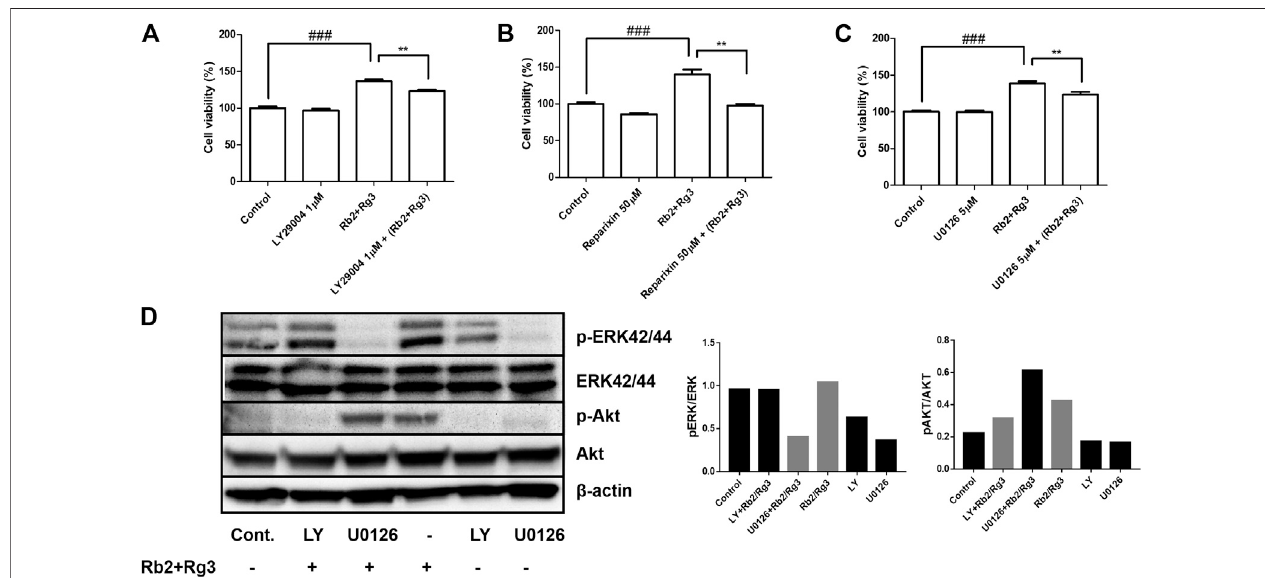
FIGURE 7 | Effects of selective inhibitors of Akt ( (A) ; LY294002), CXCR1/2 ( (B) ; Reparixin) and ERK ( (C) ; U0126) on Rb2/Rg3-induced cell proliferation as monitored by the CCK-8 assay, indicating the pro-proliferative effects of the combination were due to activation of at least those three pathways. The effect of the CXCR1/2 inhibitor was most profound and entirely inhibited the stimulation of cell proliferation due to ginsenoside treatment. Data represents mean ± SD, n (cid:2) 4. ** p < 0.005 and ### p < 0.001. (D) Phosphorylation of Akt and ERK by the combination of Rb2 and Rg3 in the presence or absence of LY294002 and U0126 as measured by western blotting and the density of bands were measured. LY294002 and U0126 completely inhibited the promoting effects of Rb2 and Rg3 on the phosphorylationofAktandERK,respectively.TheseresultsdemonstratethatAktandERK,andtheirphosphorylation,areessentialforthepro-proliferativeeffectsofthe Rb2/Rg3